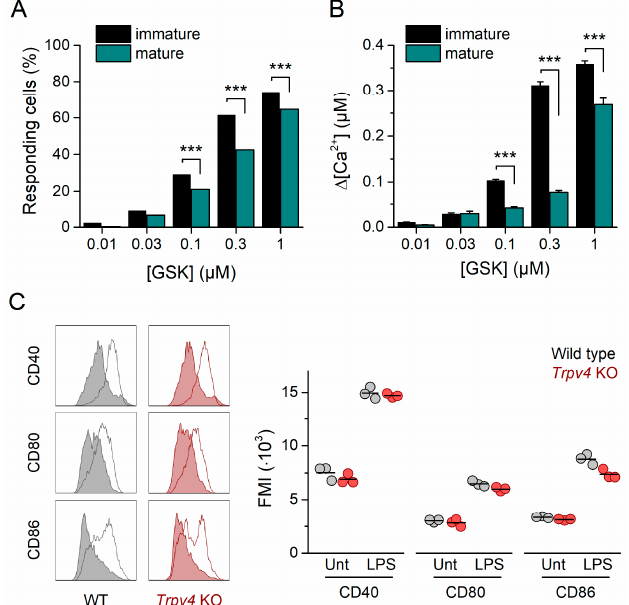
Figure 3. TRPV4 was downregulated in mature CD11c + BMDCs. ( A ) Concentration dependence of immature (black bars) and mature (dark cyan bars) CD11c + BMDC responding fraction. ***, p < 0.001, Fisher’s exact test. ( B ) Average amplitude of the responses of immature (black) and mature (dark cyan) CD11c + BMDCs to GSK1016790A applied at various concentrations ( n > 300 per data point). ***, p < 0.0001, two-tailed unpaired t -test. ( C ) Representative histograms of WT and Trpv4 KO CD11c + BMDCs untreated (shaded histogram) or treated (empty histogram) with lipopolysaccharide (LPS). Cells were harvested after six days of differentiation and incubated with 100 ng/mL of LPS for 24 h. Histograms correspond to living, single cells gated within the CD11c + population. The right panel shows corresponding mean fluorescence intensity (MFI) values for CD40, CD80, and CD86 expression in WT and Trpv4 KO BMDCs untreated or treated with 100 ng/mL of LPS for 24 h. Data points correspond to living, single cells gated within the CD11c + population. The horizontal bar represents the mean of three independent experiments. Unt, untreated cells. LPS, LPS-treated cells. The recognition of LPS by TLR4 is followed by the endocytosis of the TLR4 signaling complex, a Ca 2+ -dependent process that constitutes a crucial early event in the responses of macrophages to